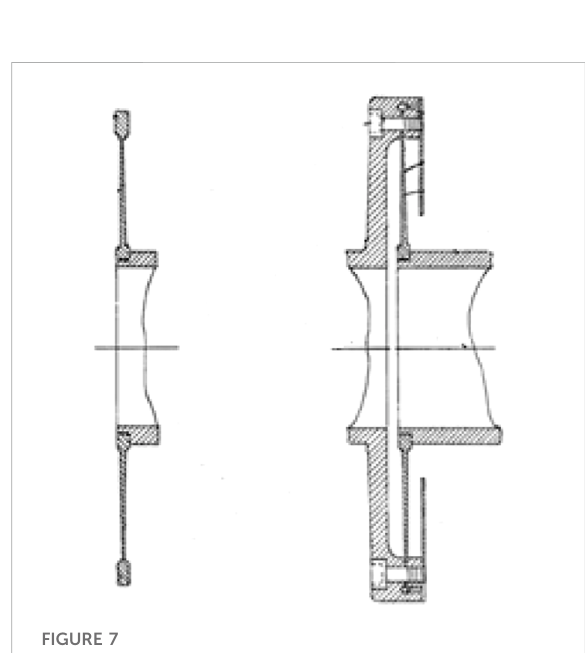
FIGURE 7 Hyperbolic single diaphragm